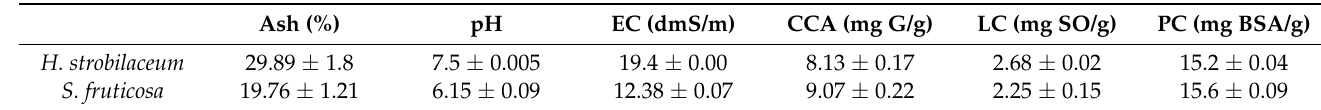
Table 3. The ash, pH/electrical conductivity, and macronutrients content (carbohydrates, lipids, and proteins) of H. strobilaceum and S. fruticosa .